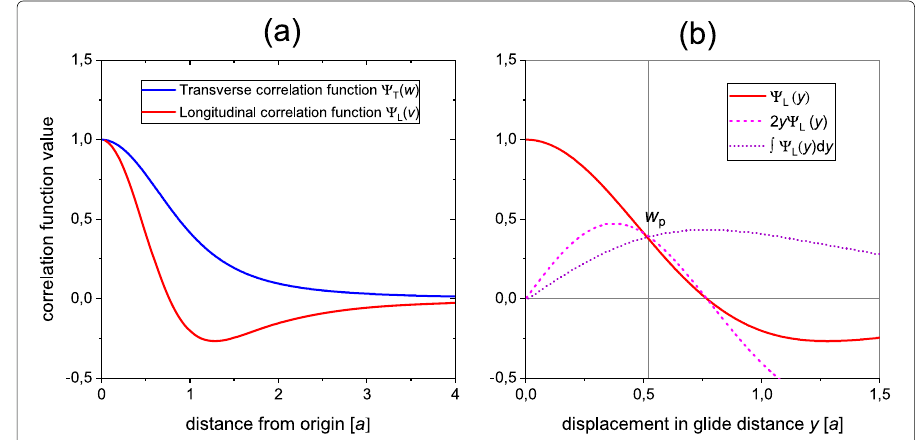
Fig. 1 (a) Longitudinal and transverse correlation functions of the fluctuating shear stress in an effective medium with random volumetric misfit, blue: transverse correlations, red: logitudinal correlations, (b) determination of the optimal pinning displacement for an edge dislocation from the longitudinal correlation